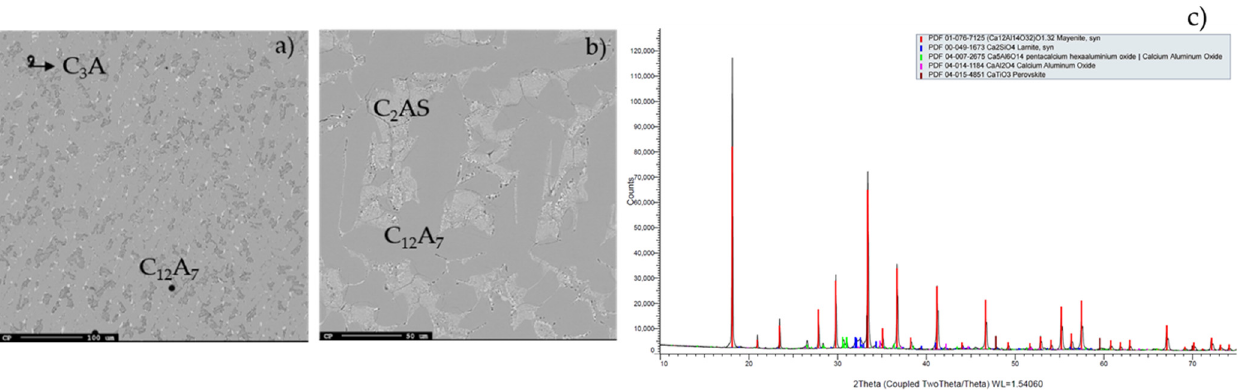
Figure 1. Micrographs of the slags produced from ( a ) Jamaican bauxite with quicklime, and ( b ) Jamaican bauxite with limestone. ( c ) XRD analysis of Greek slag.